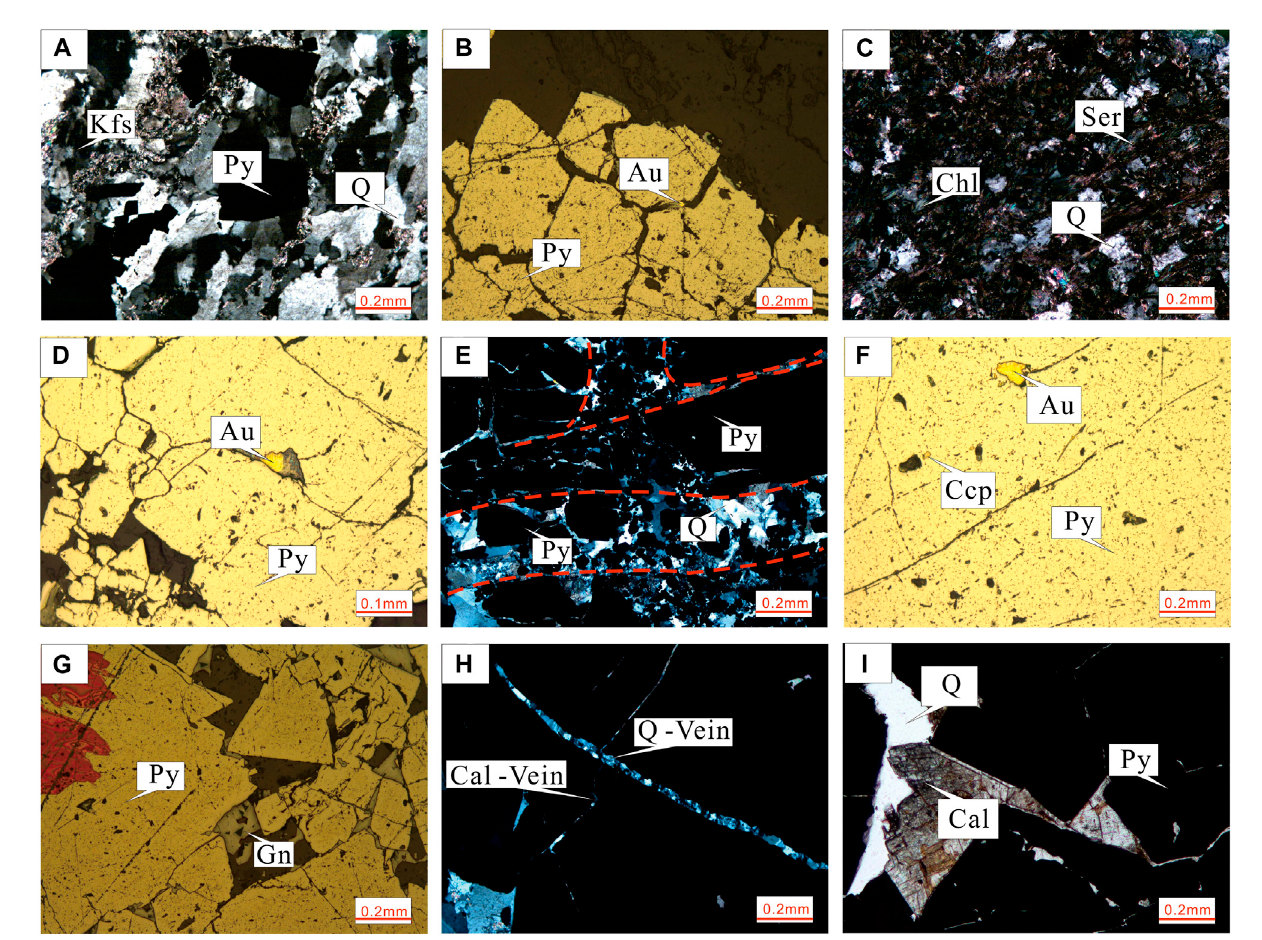
FIGURE 6 Photomicrographs of ores and altered rocks from the different metallogenic stages at Zhaoxian: (A) and (B) Pyrite-quartz-K-feldspar stage; (C) and (D) Pyrite-quartz-sericite stage; (E,F) and (G) Polymetallic sul fi de-quartz stage; (H) and (I) Quartz-calcite stage. Abbreviations: Au-Native gold; Py-Pyrite; Ccp- Chalcopyrite; Gn-Galena; Q-Quartz; Kfs-K-feldspar; Chl-Chlorite; Cal-Calcite;